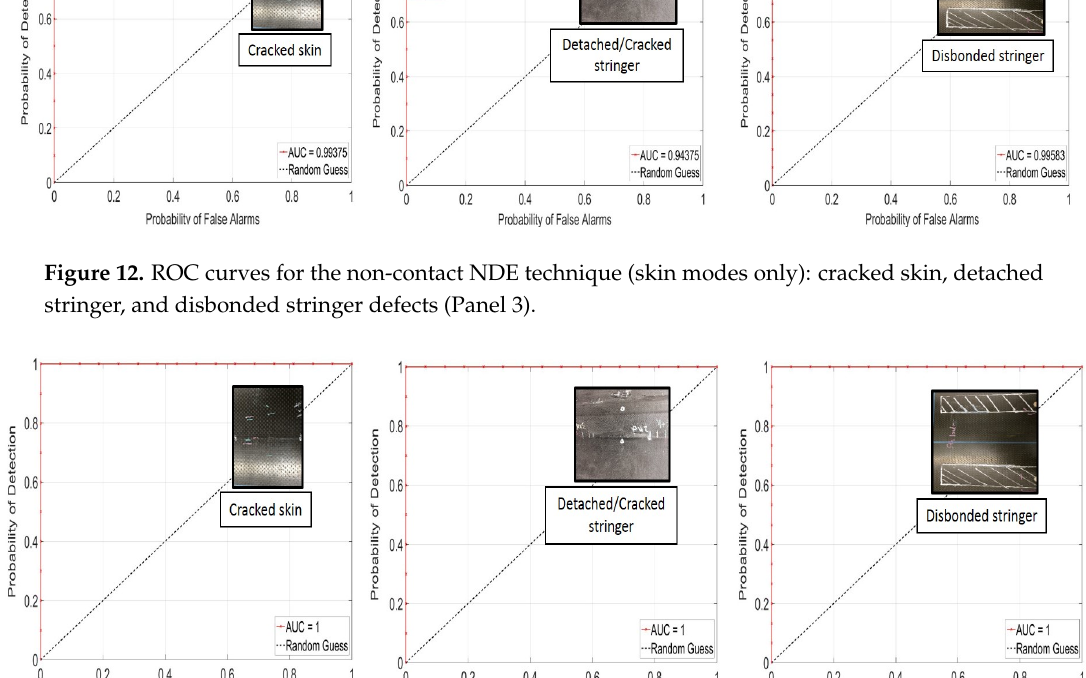
stringer, and disbonded stringer defects (Panel 3).